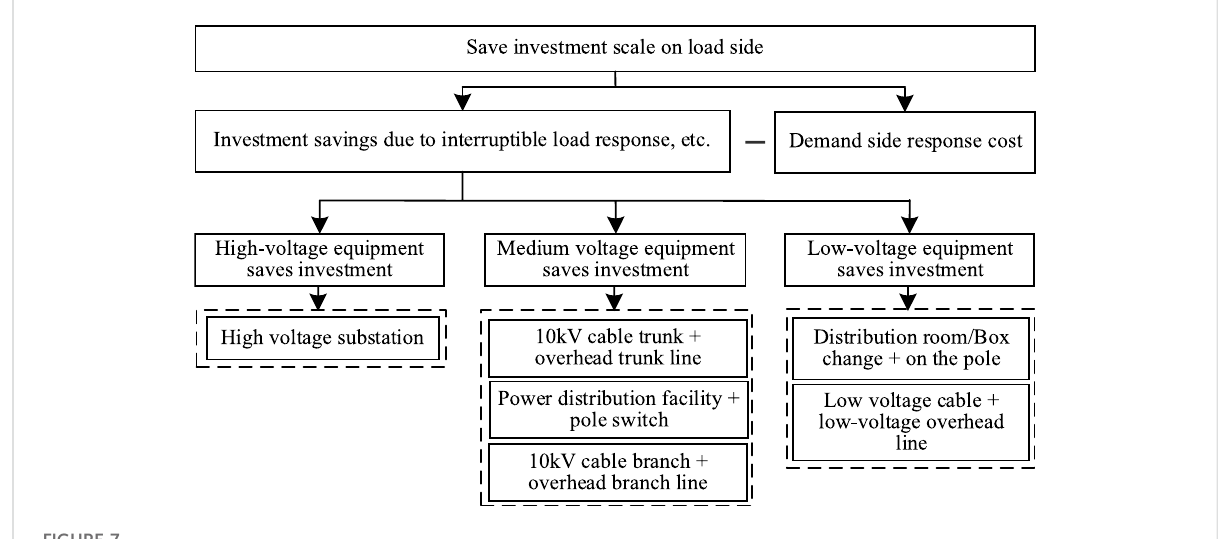
FIGURE 7 Flow chart of the scale of investment savings on the load side in the coming